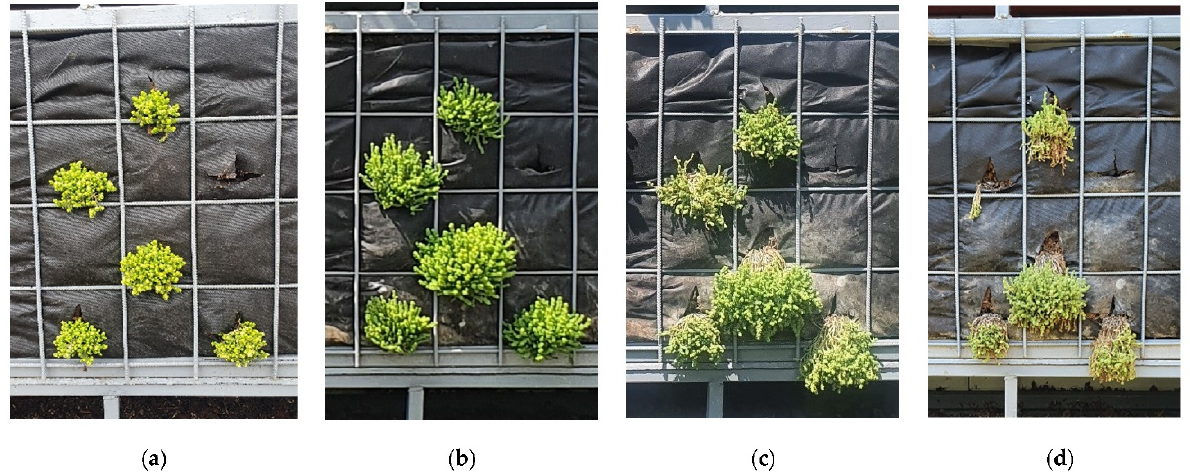
Figure 7. Evolution of Sedum acre March–July 2020, level 2 eastern facade: ( a ) 3 March 2020; ( b ) 2 May